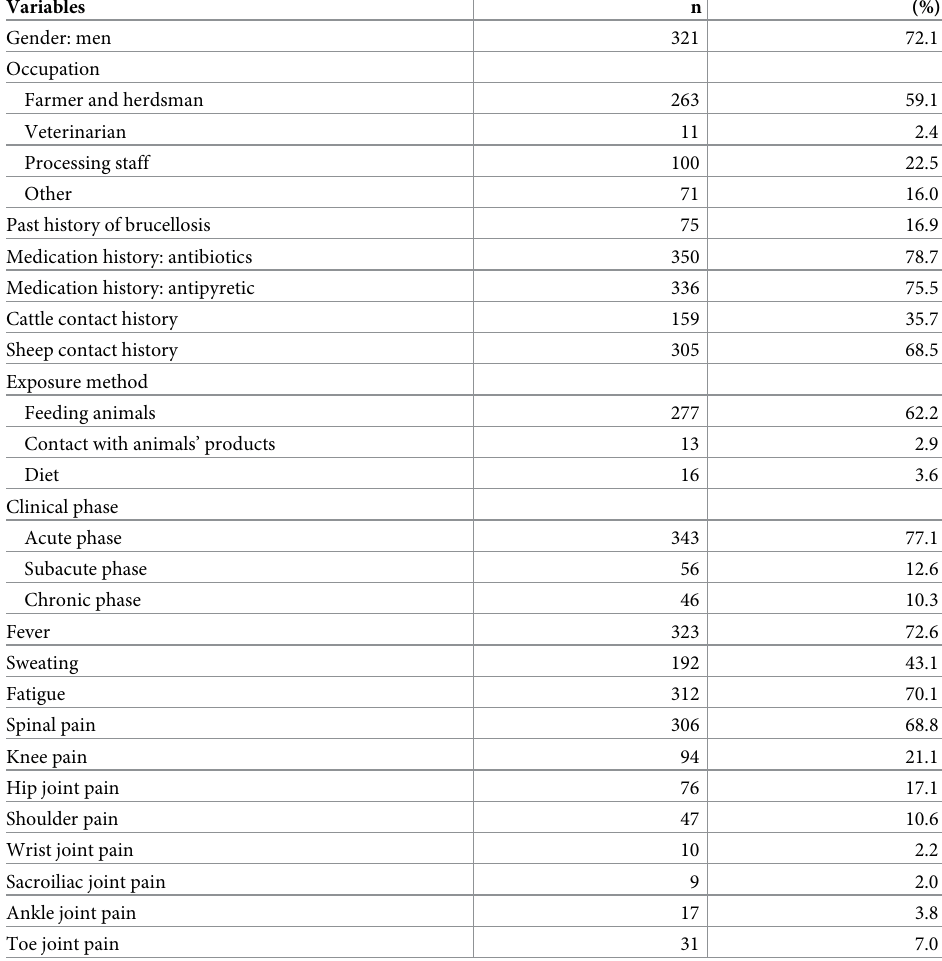
Table 1. Demographics, personal characteristics and clinical manifestations in 445 brucellosis patients with arthralgia. Variables n (%)